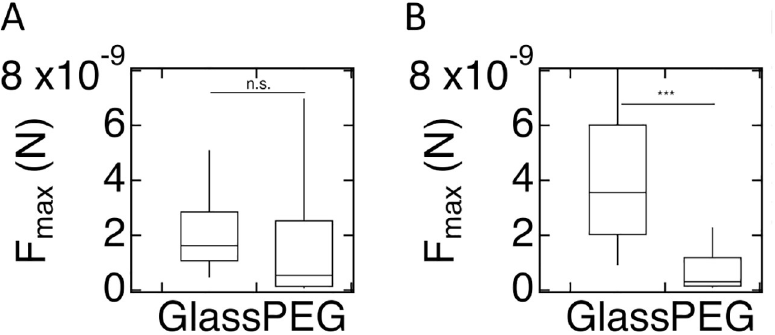
Fig 7. Maximum force of adhesion for developed cells. A) Box plot of the distribution of F glass and PEG-gel surface, where the bottom and the top of the box represents the first and the third quartiles, and the band corresponds to the median. The difference in F these cells, the difference in F max is